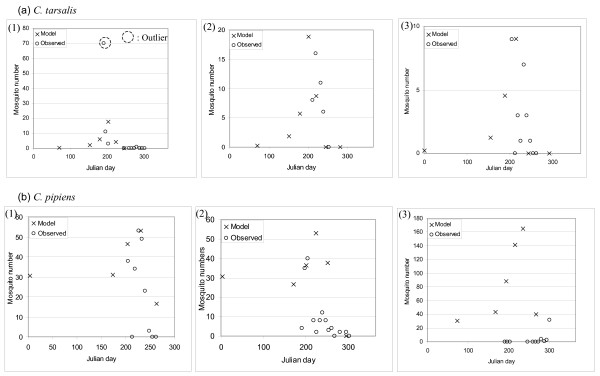
A trap-by-trap confirmation of the model performance. (a) C. tarsalis and (b) C. pipiens. The data for the two stations with largest numbers of mosquitoes observed is presented, along with data from a station in the other main region of concern. For C. pipiens, for which b (1) and b (2) traps are enough warm to support mosquitoes in the beginning of January, the initial conditions of the model result in 30 mosquitoes appearing near Julian day 1.